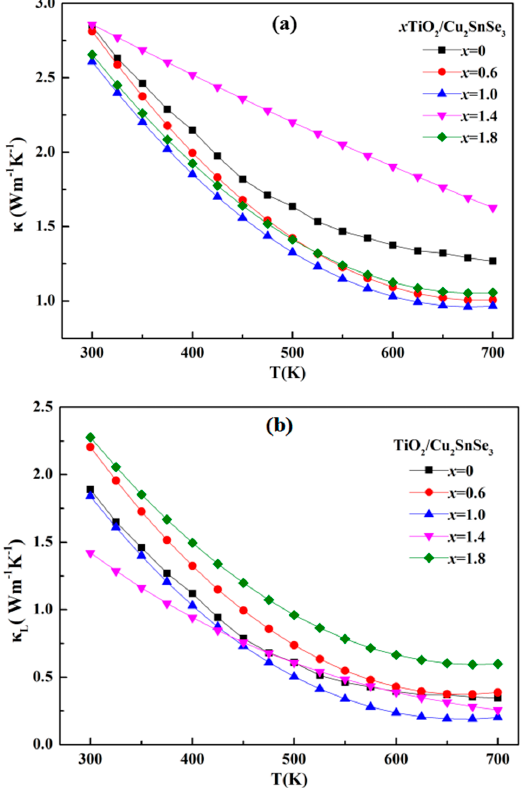
Figure 9. ( a ) Temperature dependence of total thermal conductivity and ( b ) lattice thermal conductivity for the TiO 2 /Cu 2 SnSe 3 composites.